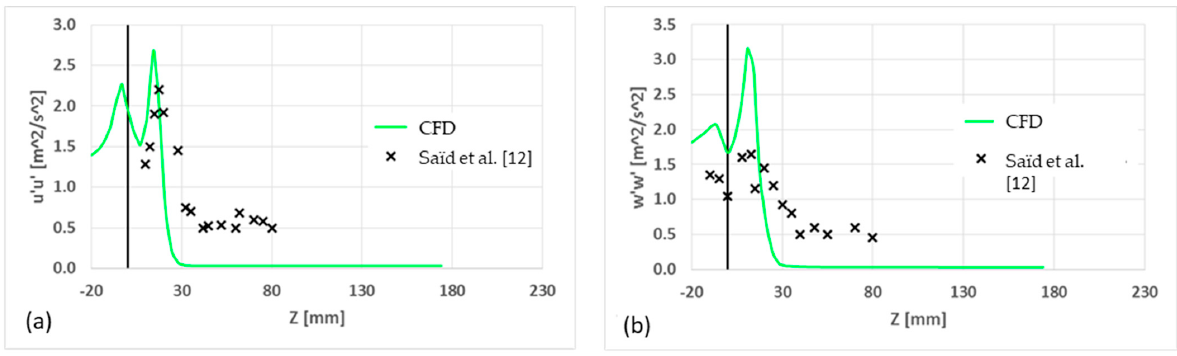
Figure 5. Flow velocity components at section x = 16.7 [mm]—( a ) U component and ( b ) W component [12].